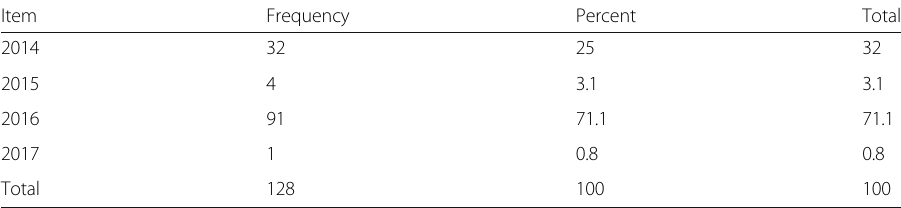
Table 3 Graduation year of training scholarship awarded trainees Item